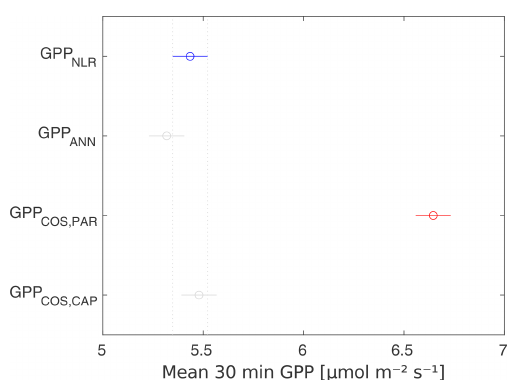
Figure B4. ANOVA test results for 30min GPP data. Gray bars indicate no difference to the reference (blue), and red bars indicate statistical difference to the reference. The results show that only GPP COS,PAR differs statistically from GPP NLR at 30min timescale.